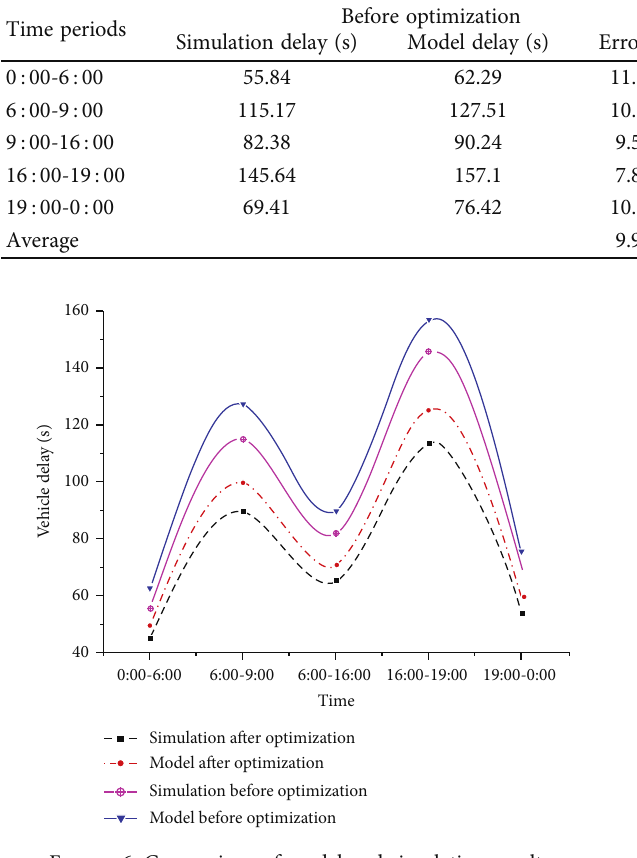
Figure 6: Comparison of model and simulation results.